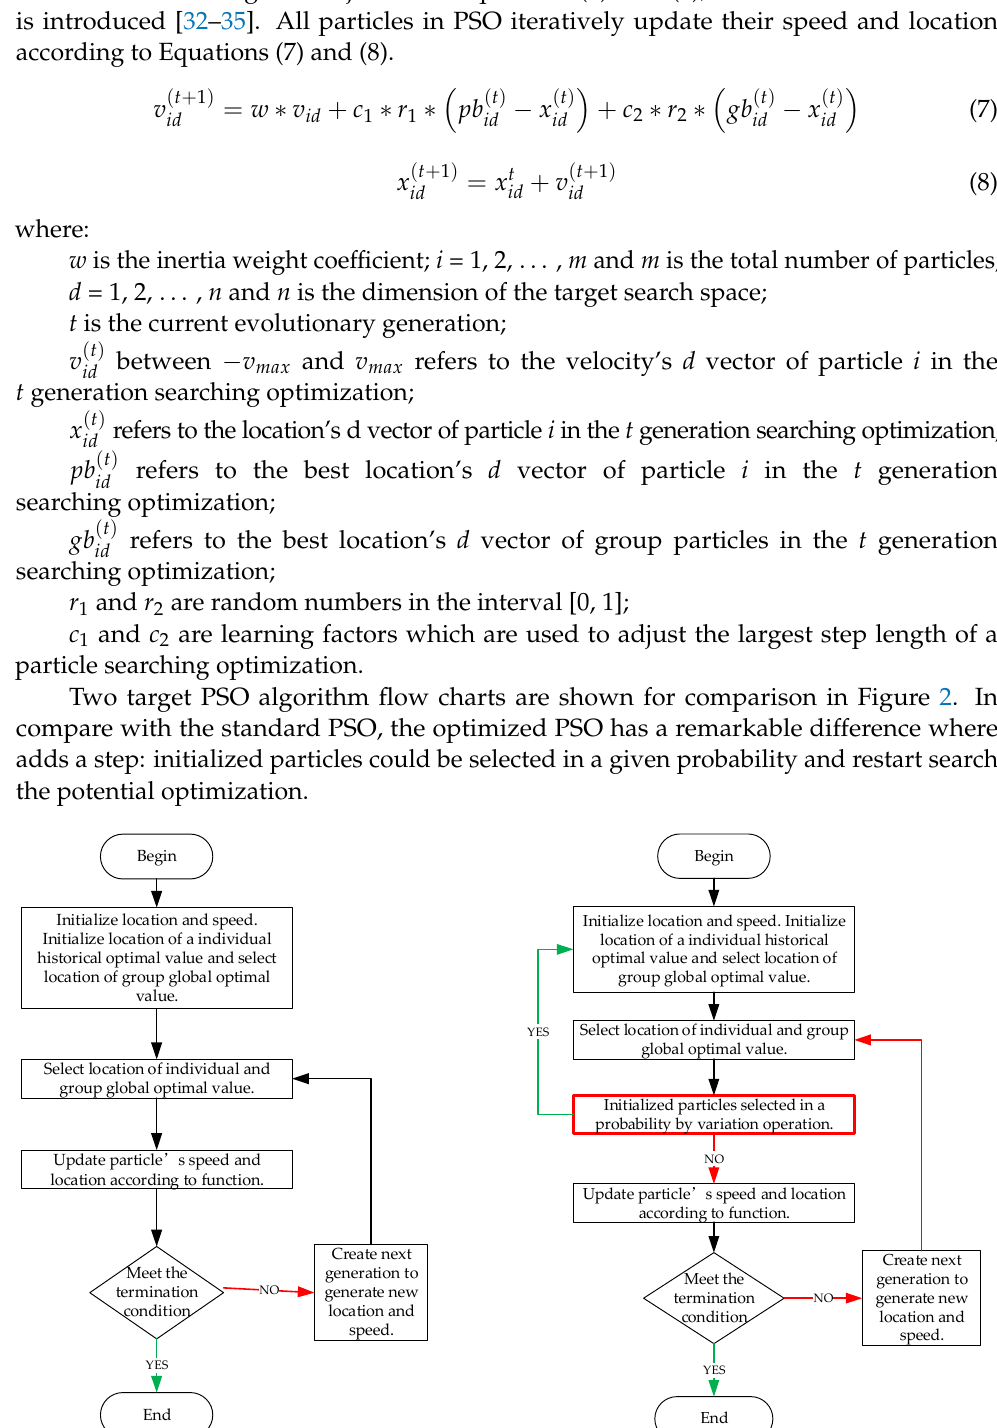
Figure 3. Comparison of optimized processes using MATLAB. Figure 3 shows that the optimized algorithm has a fitness value approaching 0 and is almost certainly convergent before 20 generations. In the inset, L along the x–axis indi ‐ cates that optimized PSO requires fewer evolutionary iterations than standard PSO to reach 0 fitness. We found that the advantages in Figure 3 are as follows: (1) the optimiza ‐ tion algorithm is able to iterate for fewer generations for the same confidence value. (2) the optimization algorithm can obtain better confidence values for the same number of iterations. Thus, optimized PSO is better than standard PSO in global optimization and